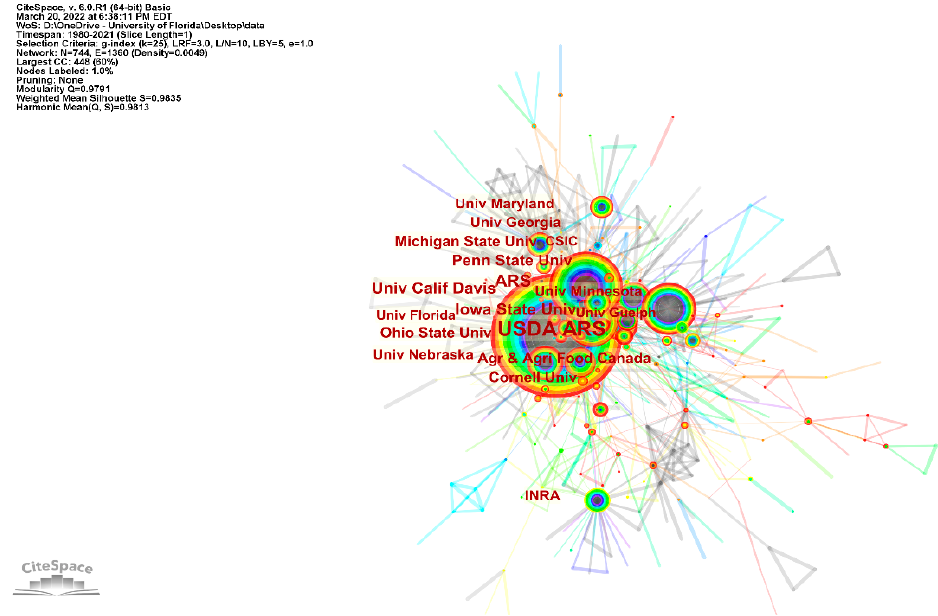
Figure 8. The results of institution cooperation network analysis.